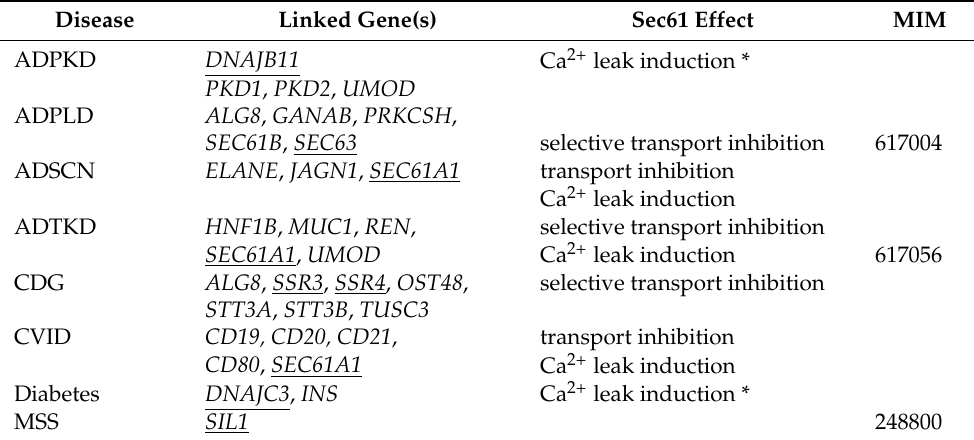
Table 3. Human hereditary Sec61 channelopathies and related